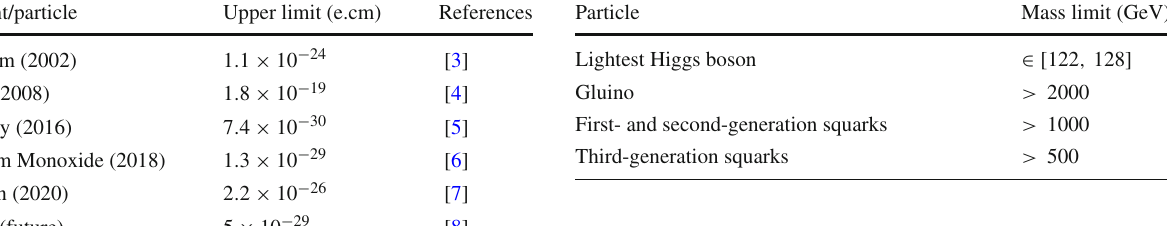
Table 1 The 95% C.L. upper limits on EDMs used as constraints in this study Element/particle Upper limit (e.cm)